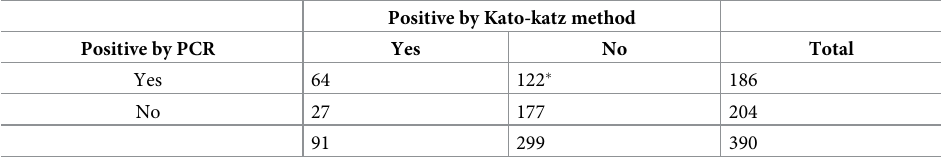
Table 4. 2x2 table of PCR and Kato-katz results.